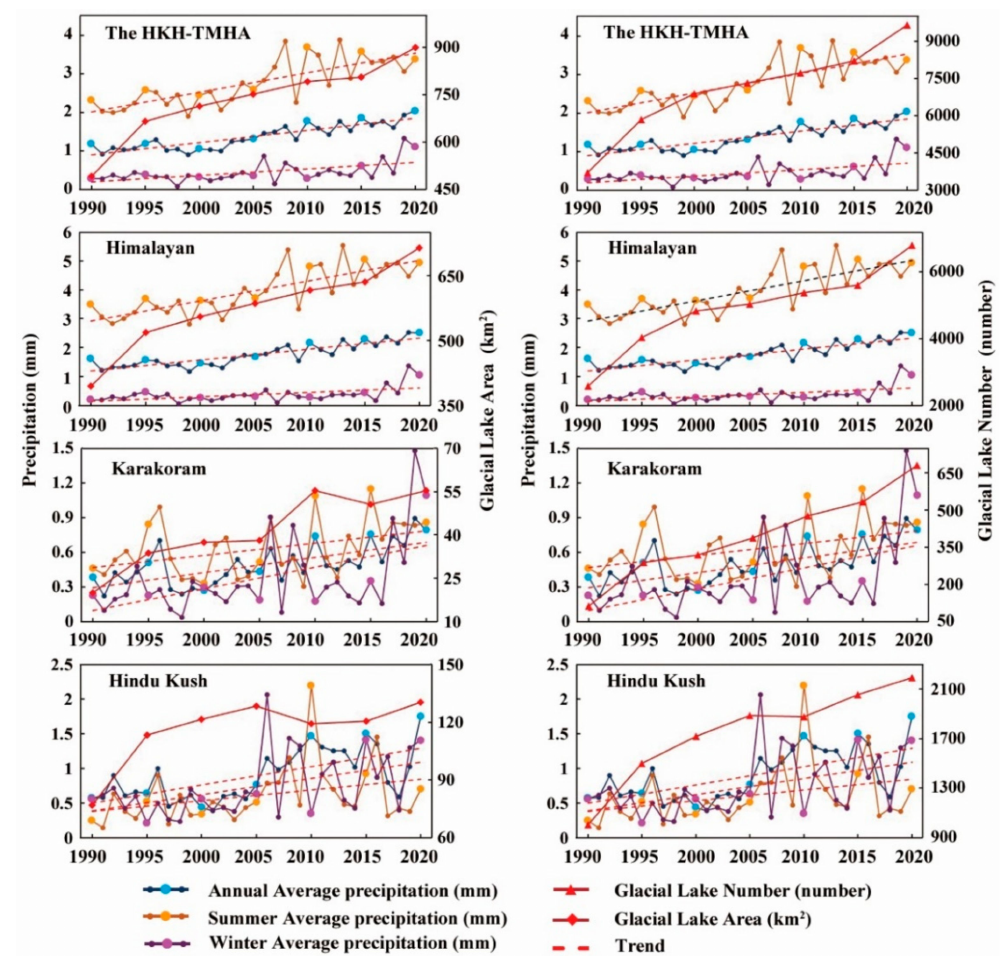
Figure 15. Time series of daily average